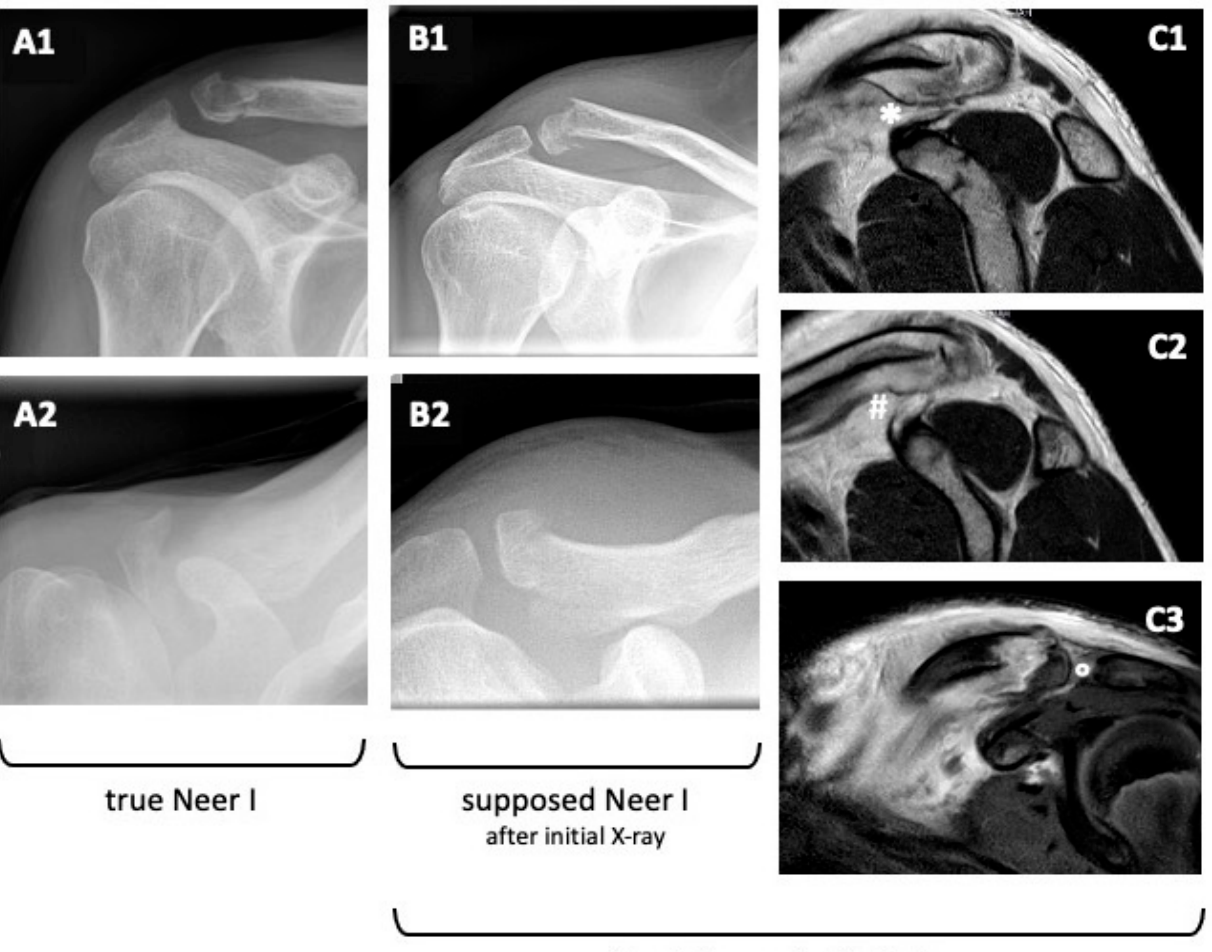
Figure 2. (A1 , A2 ): Exemplary X-rays of a type I fracture according to the modified Neer classification. ( B1 , B2 ): X-rays of a fracture initially classified as Neer I (time [A]). ( C1 – C3 ): MRI of the fracture shown in ( B1 , B2 ). It shows a ruptured conoid ligament [#] as well as a ruptured trapezoid ligament [*] but an intact acromioclavicular capsule and ligament [ ◦ ]. Thus, by definition, this is an unstable type of Craig IIc.